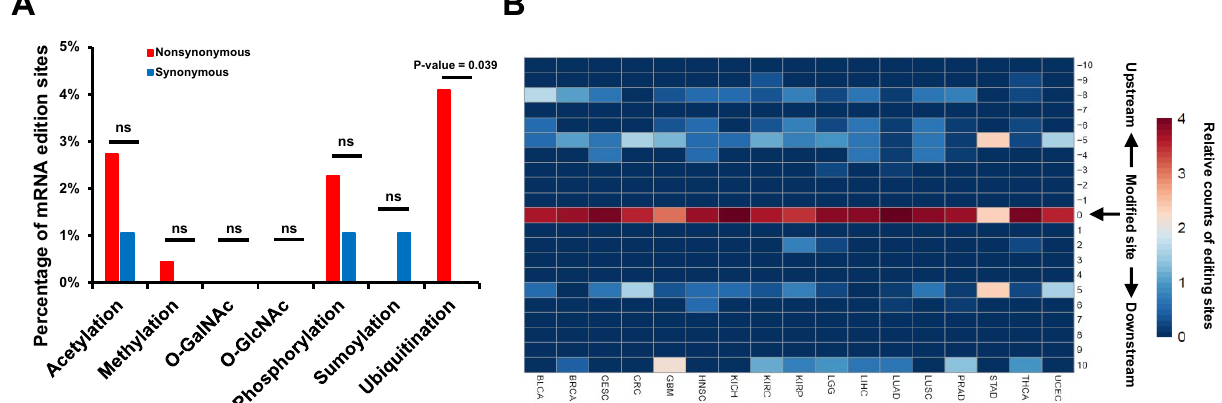
Figure 3. Overlaps between RNA editing and protein modification sites in cancers. ( A ) Bar plot demonstrating the percentage of nonsynonymous RNA editing located in the protein modification sites in TCGA database. The P-value was computed by one-sided “fisher.test” function in R. ( B ) Heatmap displaying the distribution of nonsynonymous RNA editing on ubiquitination site and flanking regions in each cancer type from TCGA